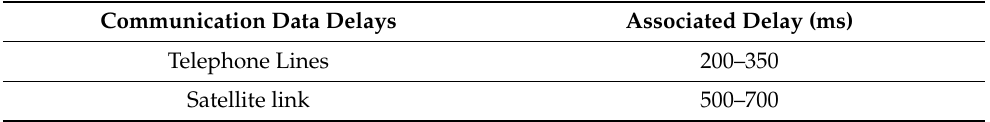
Table 2. An example of telecommunications data